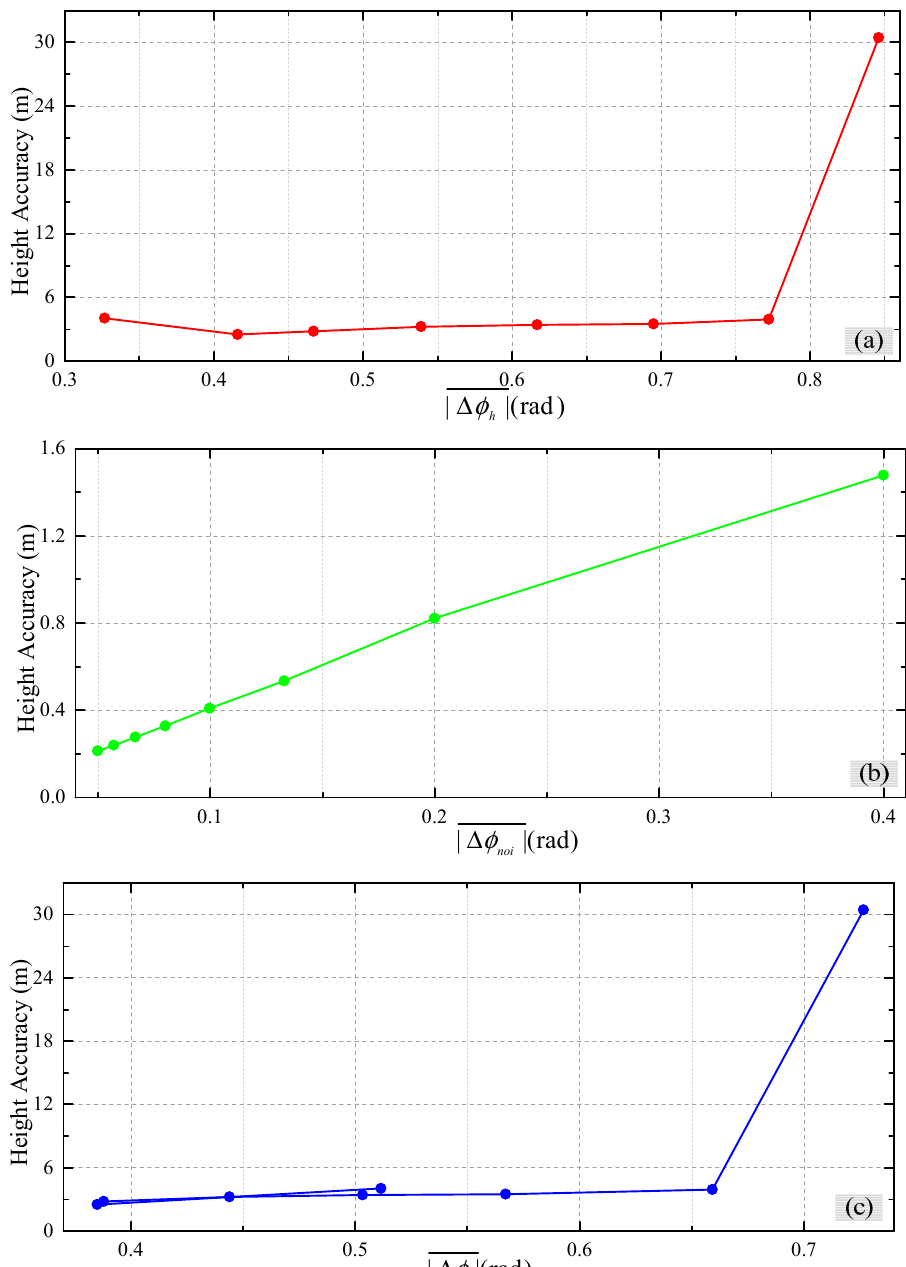
Figure 7. ( a – c ) Relationship between the height accuracy and the mean values of absolute phase gradient, absolute noise phase gradient and absolute phase gradient.